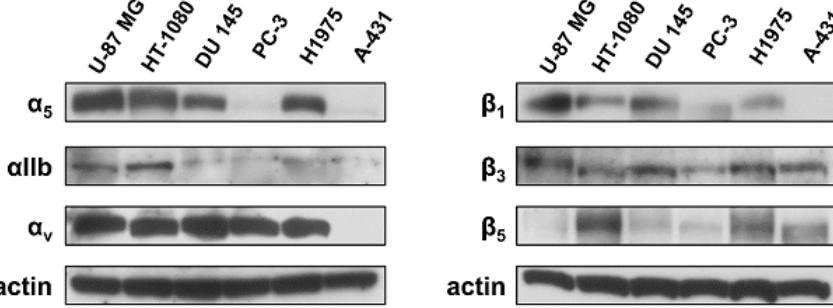
Figure 2. Expression of integrin chains in a panel of cancer cell lines. Whole cell lysates from U-87 MG, HT-1080, DU 145, PC-3, H1975 and A-431 cells were subjected to western blot analysis to determine levels of α 5, α IIb, α v, β 1, β 3 and β 5 integrin chains. Actin ensured equal loading.